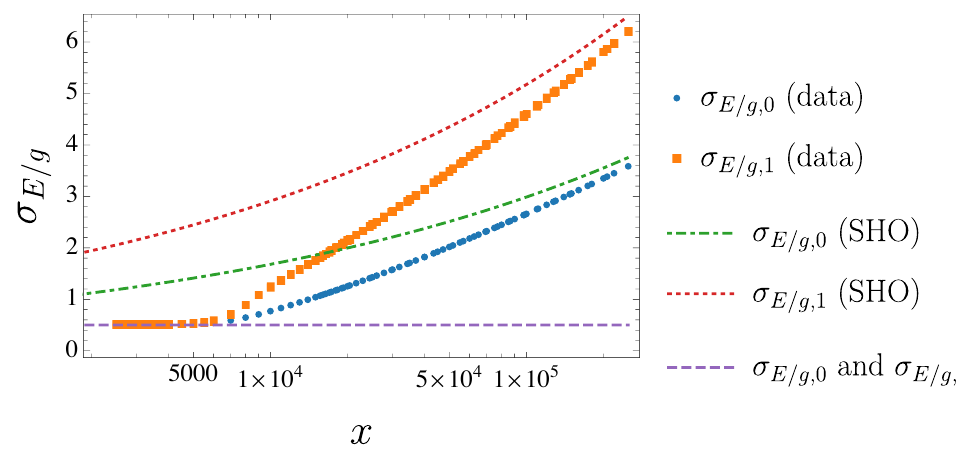
and σ . The E/g, 0 E/g, 1